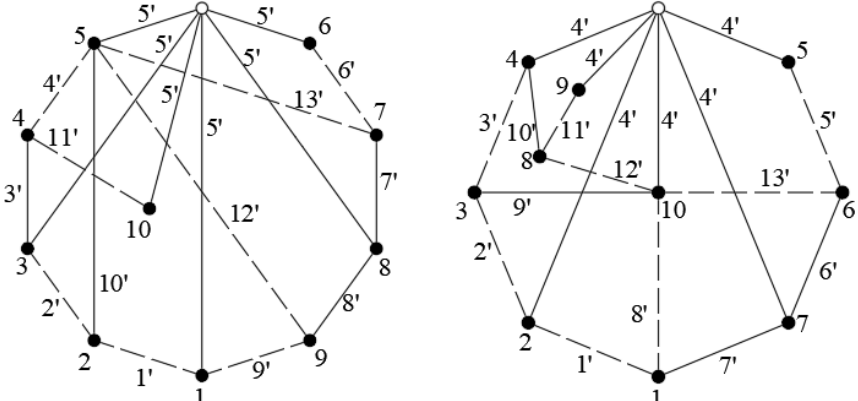
Figure 5. The topological graphs of 10-link EGTs c 1 and c 2